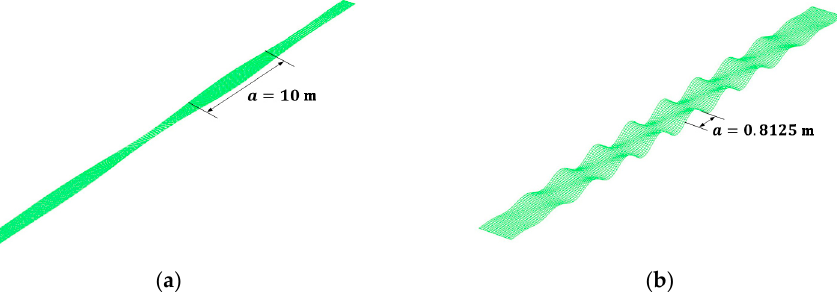
Figure 10. Local buckling mode shapes based on elastic buckling analysis: ( a ) hinge support condition and ( b ) fixed support condition.